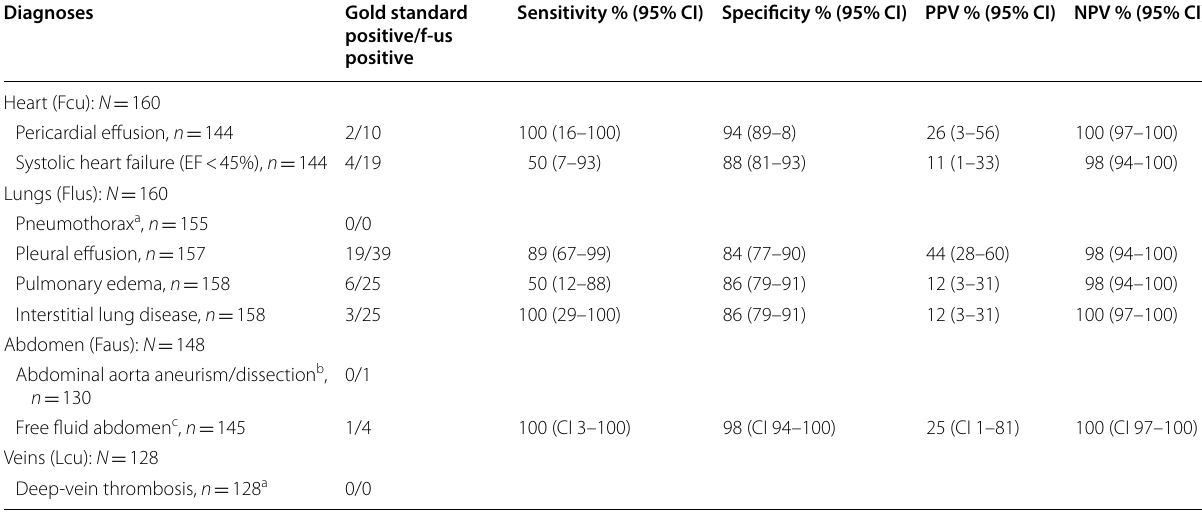
Gold standard: final diagnoses of blinded medical record audit Statistical analyses are made using the statistical concept ‘per protocol’: cases of no ultrasonography clips are left out Number of patients with an ultrasonography examination sufficient for diagnostic evaluation for each protocol ( N ) and for each pathology ( n ) F-us fo c used ultrasonography, Fcu focused cardiac ultrasonography, Flus focused lung ultrasonography, Faus focused abdominal ultrasonography, Lcu limited compression ultrasonography a Due to a low number of events the sensitivity and specificity could not be calculated b Signs of aorta aneurism or dissection are defined as a deviation from the normal diameter (women < 2.9 cm, men < 3.2 cm) of the abdominal aorta